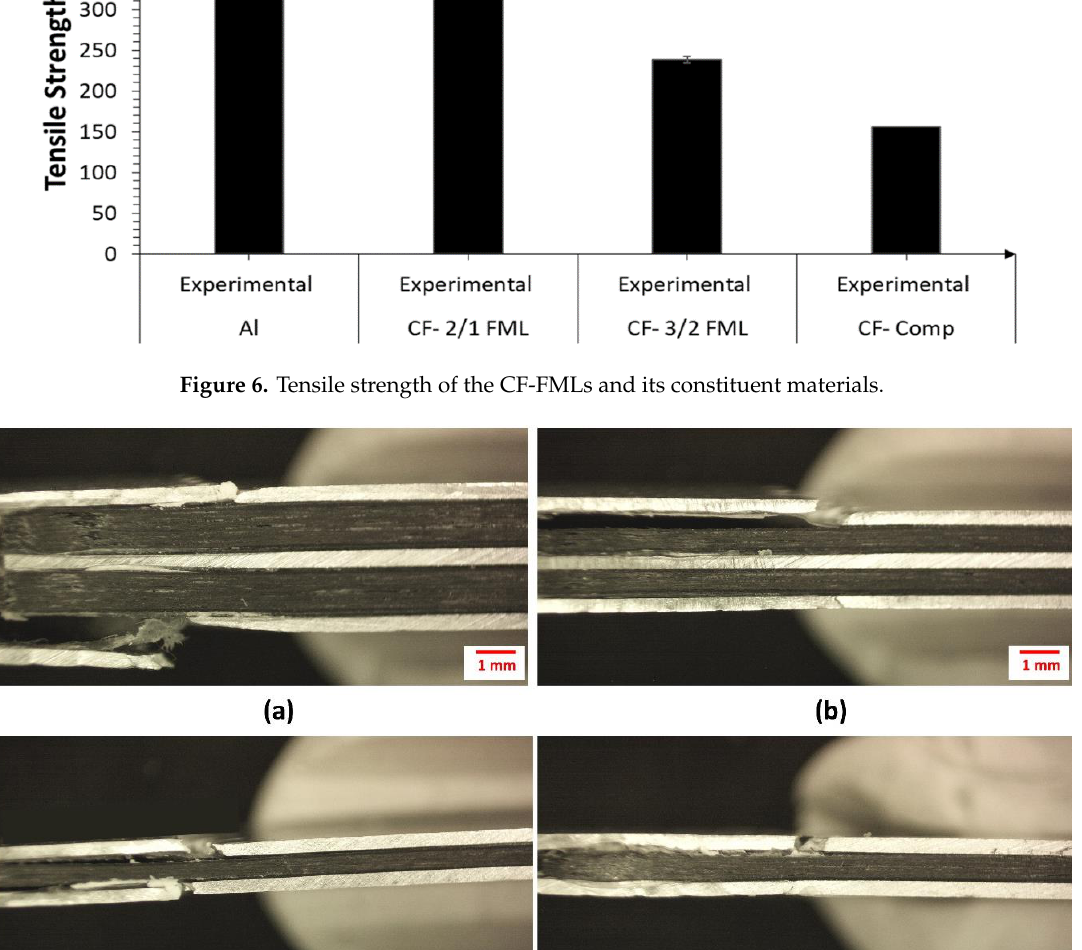
Figure 7. Tensile FML samples with ( a ) and ( b ) 3/2 configuration and ( c ) and ( d ) 2/1 configuration.